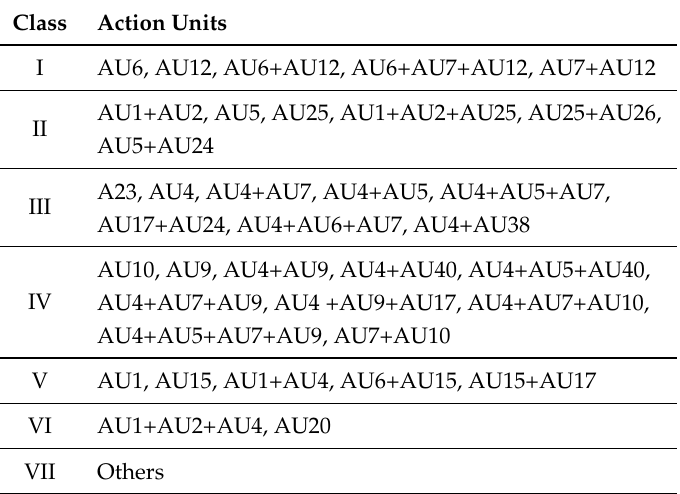
Table 2. Each class represents AUs that can be linked to